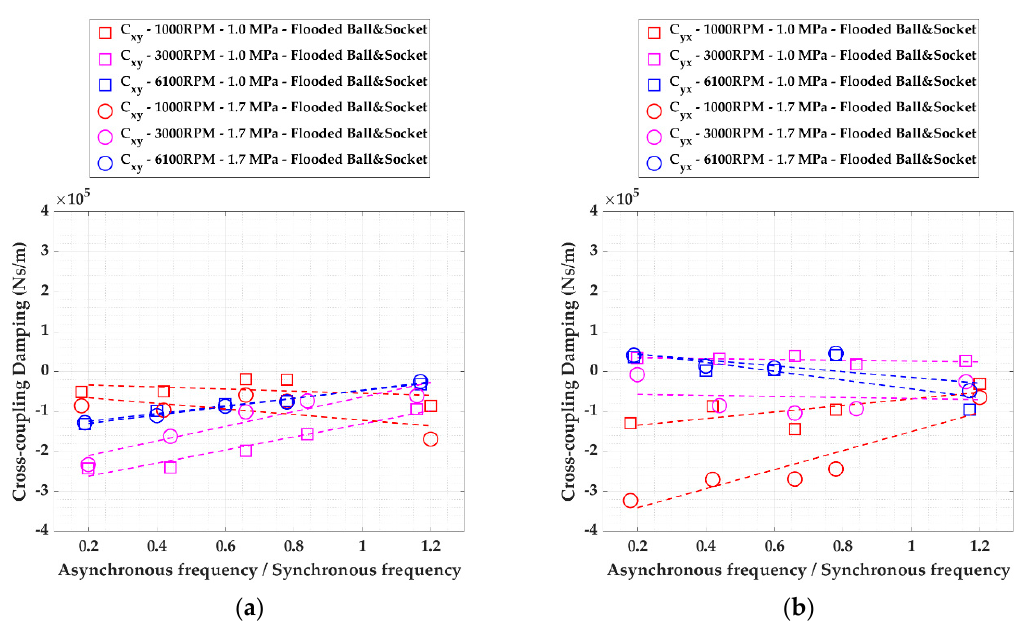
Figure A10. Flooded Ball & Socket Pivot bearing asynchronous cross-coupling damping coefficients at various speeds for 1.0 MPa and 1.7 MPa: ( a ) C xy , ( b ) C yx .